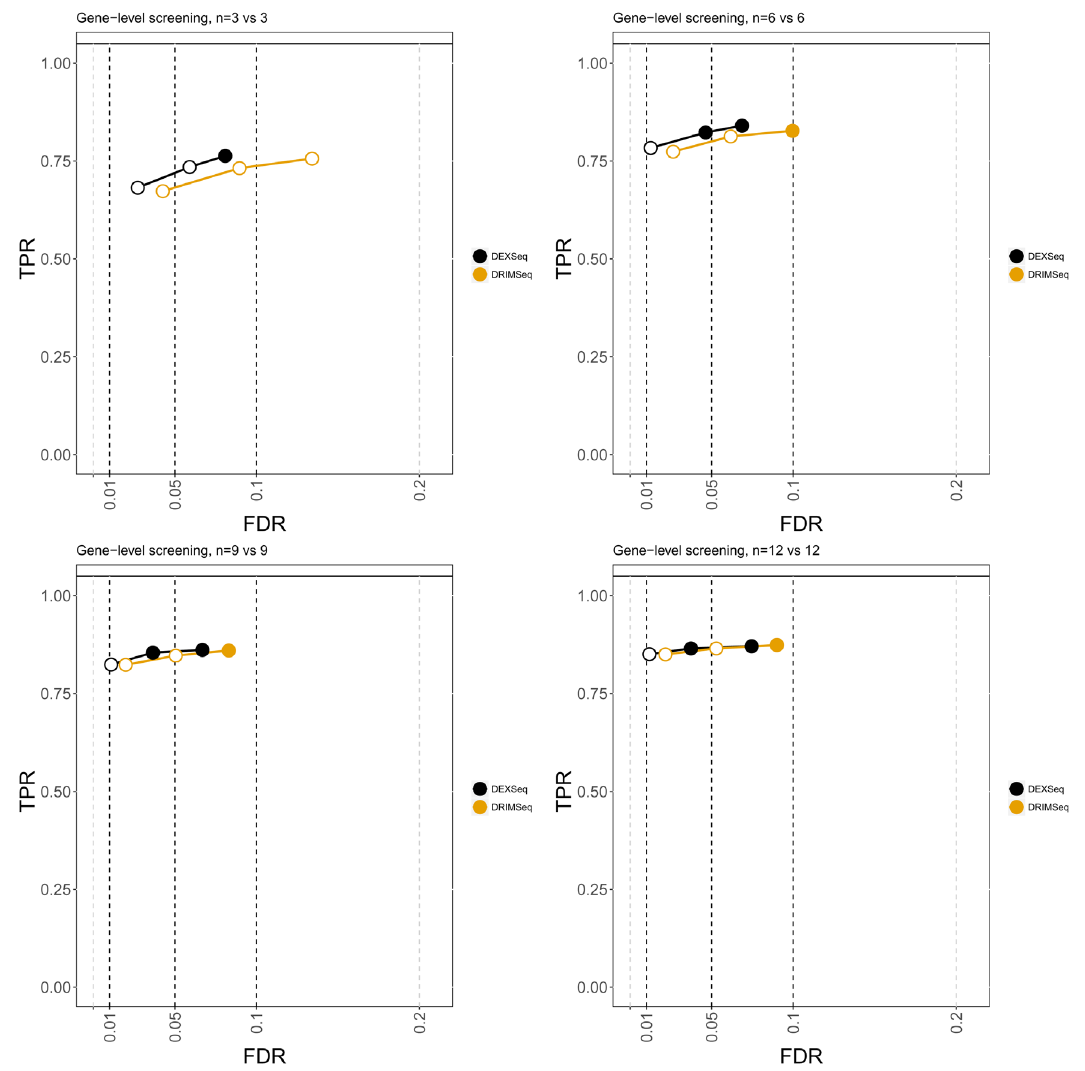
Figure 9. Gene-level screening for differential transcript usage (DTU), on the “fixed per-gene dispersions” simulation. The four panels are for per-group sample sizes: 3, 6, 9, and 12, as indicated in the title. Circles indicate thresholds of 1%, 5%, and 10% nominal